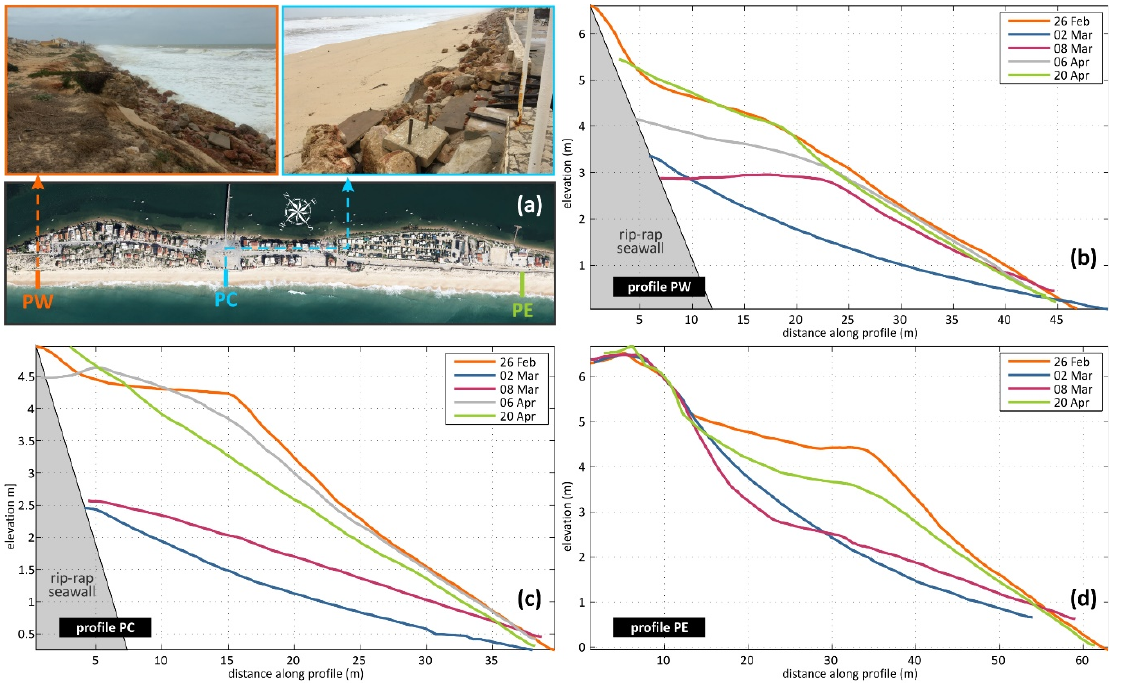
for Faro. The yellow-shaded area on the plots denotes the incidence of Emma storm (28 February–5 March), green arrows show the dates of profile measurement and identified storm and non-storm conditions are marked (orange and blue, respectively) on the timeline above ( a ).